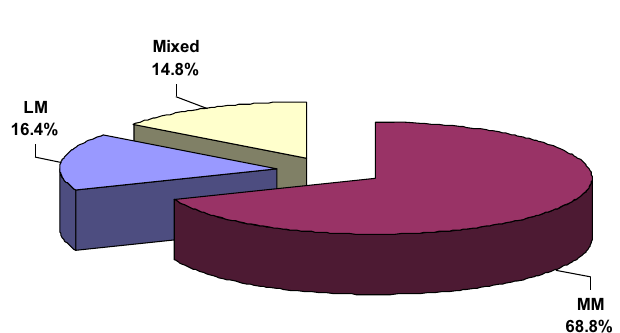
Figure 3. Percentage of meniscal tear between medial and lateral menisci.